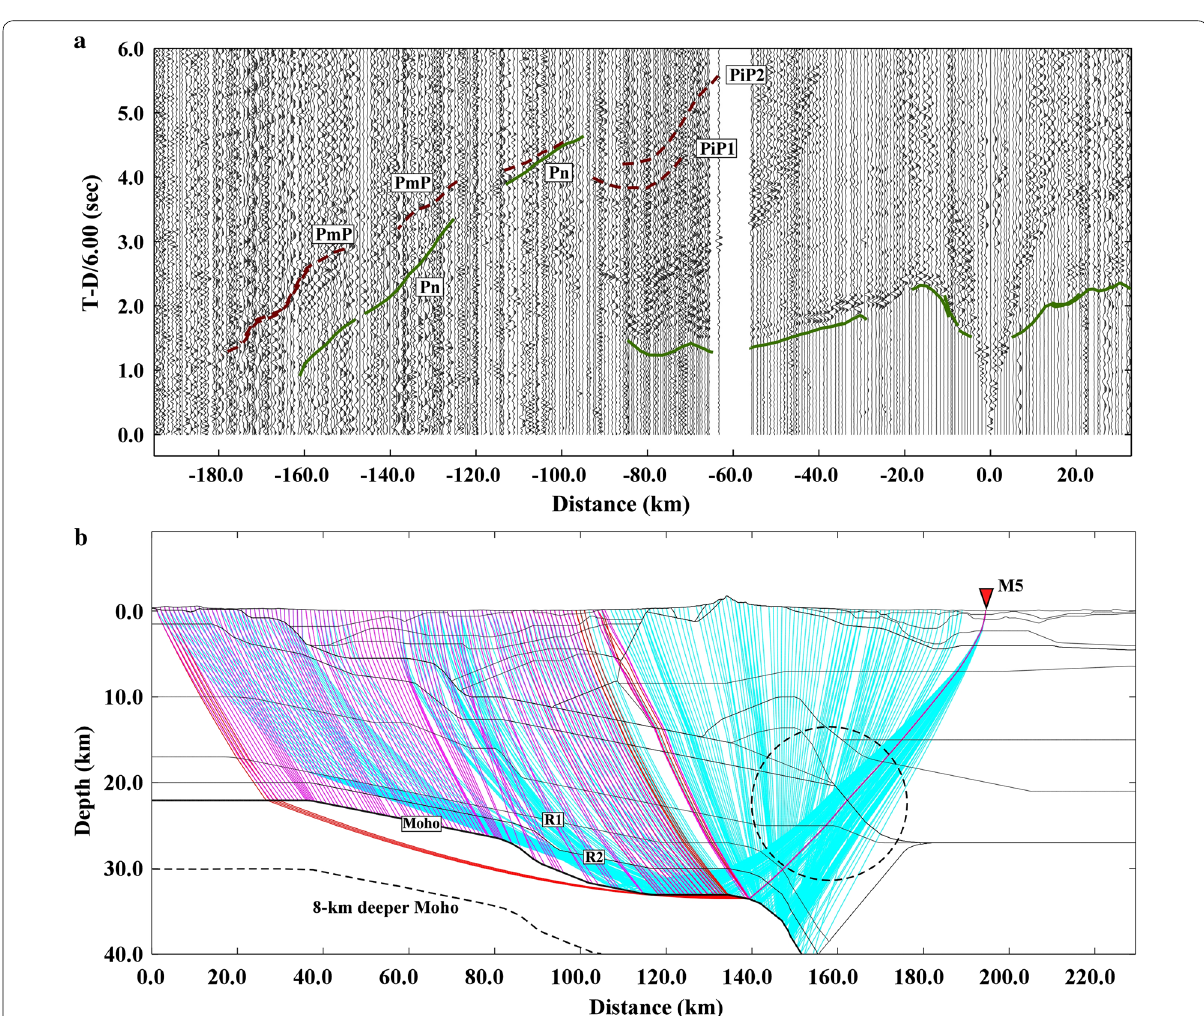
Fig. 8 Record section with theoretical travel times and ray diagrams for shot M5. a Record section for shot M5 on which travel time curves from the velocity model (Fig. 5a) are shown. Travel times of first arrival are shown by a green line. Phases “A” and “B” recognized at far offsets (Fig. 6b) are interpreted to be Pn and PmP waves, respectively. PiP1 and PiP2 waves are reflections from interfaces of R1 and R2 (see b ). These phases appear only in the eastern part of the profile, but not in the western part where phases “A” and “B” are noticed (see also Fig. 6b). b Ray diagram for PmP (light blue) and Pn (red) phases. A broken circle indicates the lower crustal part in the side of the Kuril Arc which are penetrated by rays from shot M5. Travel time variation by the change of velocity values in this region was calculated to check our Moho depth estimation (see the text for detailed explanation). A broken curve shows the Moho location 8 km shifted